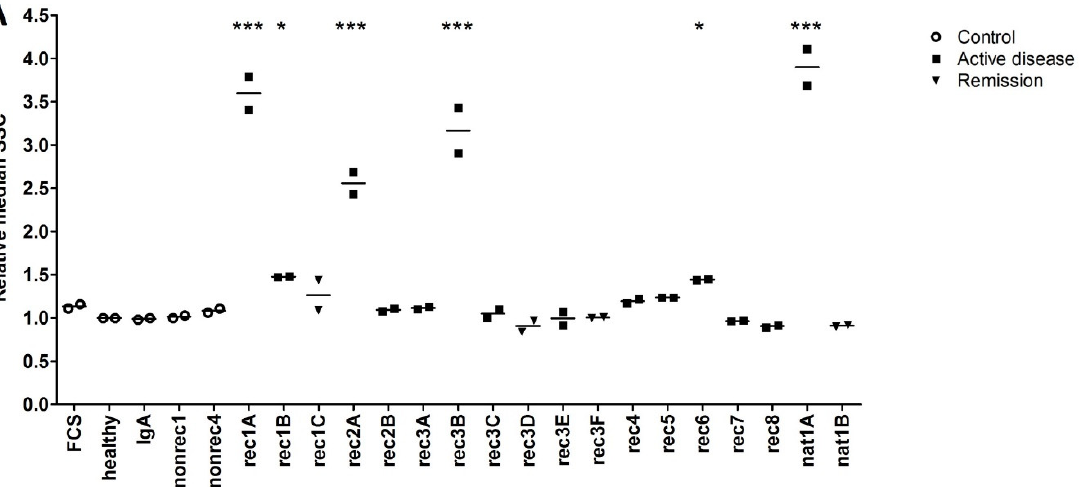
Figure 4. FSGS plasma-induced perilipin-2 expression is correlated with granularity in hPod. ( A ) Granularity as measured by flow cytometry side scatter (SSC). Median SSC of two replicate experi- ments and their means relative to healthy plasma are depicted. Circles represent controls, squares active disease FSGS plasmas, and triangles (partial) remission plasmas. * p < 0.05, *** p < 0.001 com- pared to healthy plasma. ( B ) Correlations of median perilipin-2 fluorescence intensities (MFI) from Figure 2B with the relative median side scatter (SSC) from ( A ). Non-linear fit equation: Y = 12.13 × X/(0.9694 + X) − 0.6616 × X − 4.429. ( C ) Correlations of median perilipin-2 LFQ intensities from Figure 2A with the relative median side scatter (SSC) from ( A ). Non-linear fit equation: Y = 8.043 × 10 10 × X/(0.0093 + X) + 4.319 × 10 8 × X − 7.963 × 10 10 . FCS: fetal calf serum; healthy: pooled plasma from five healthy donors; IgA: patient with IgA nephropathy; nat: patient with FSGS in the native kidneys; nonrec: patient with non-recurrent FSGS; rec: patient with recurrent FSGS. Functional classification revealed that 14 out of the 82 differentially expressed pro- teins between proteomes of hPod exposed to high granularity-inducing and low granu- larity-inducing FSGS plasmas are involved in (sphingo)lipid and fatty acid/triglyceride metabolism (these 14 proteins are shown in Supplementary Table S4). We then hypothe- sized that the granules observed and measured with flow cytometry could be lipid drop- lets, since perilipin-2 is known to be associated with lipid droplets, and since we observed differentially expressed proteins involved in lipid metabolism. Indeed, using electron mi- croscopy, we observed accumulation of large structures in the cytoplasm of hPod after exposure to active disease plasmas nat1A (Figure 5A,C) and rec1B (Figure 5B), but not after exposure to paired remission plasmas nat1B (Figure 5D) and rec1C (Figure 5E), or healthy plasma (Figure 5F). These structures appeared circular with a homogenous core and a dark outer lining, and appeared to show fusion, which are all characteristics previ- ously described for lipid droplets (Figure 5C) [14,15].